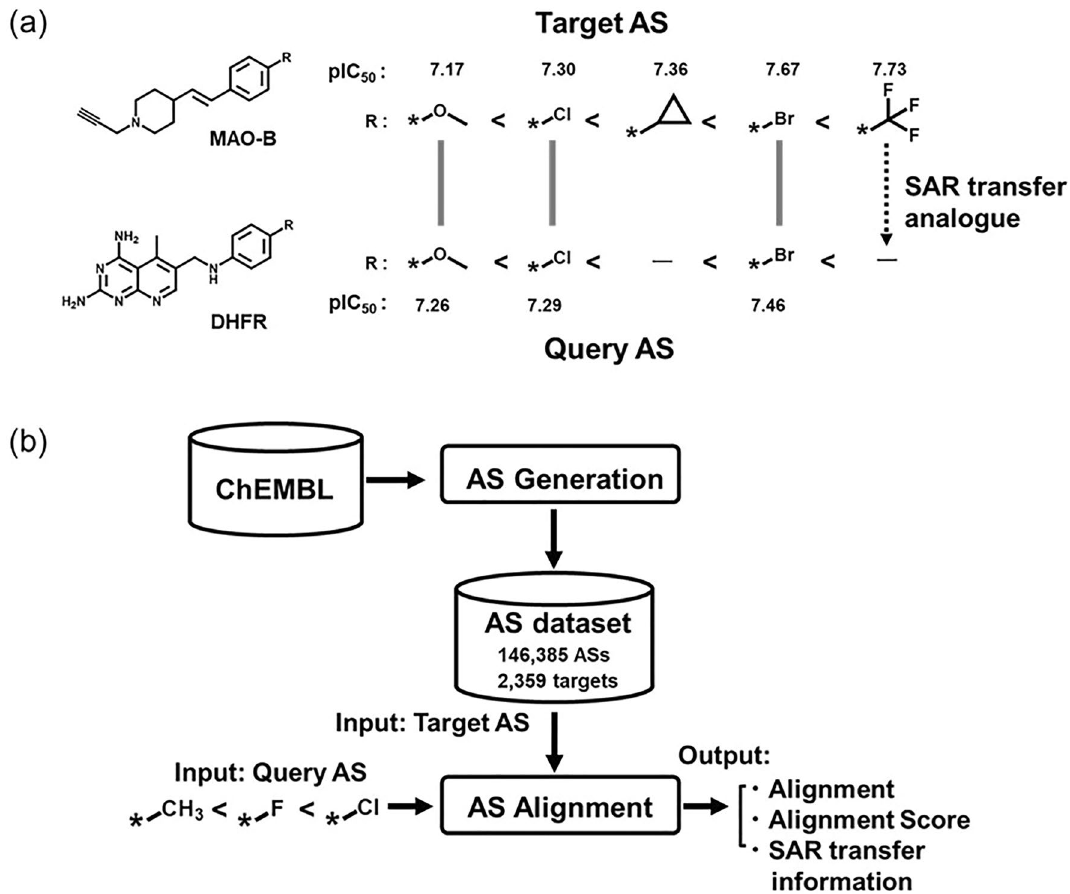
Figure 1. ( a ) An alignment of two exemplary ASs with corresponding pairs of analogues and activity against monoamine oxidase type B (MAO-B) and dihydrofolate reductase (DHFR) is shown. The dashed arrow indicates a possible SAR transfer analogue for the query AS. ( b ) Workflow for detection of SAR transfer analogue with AS